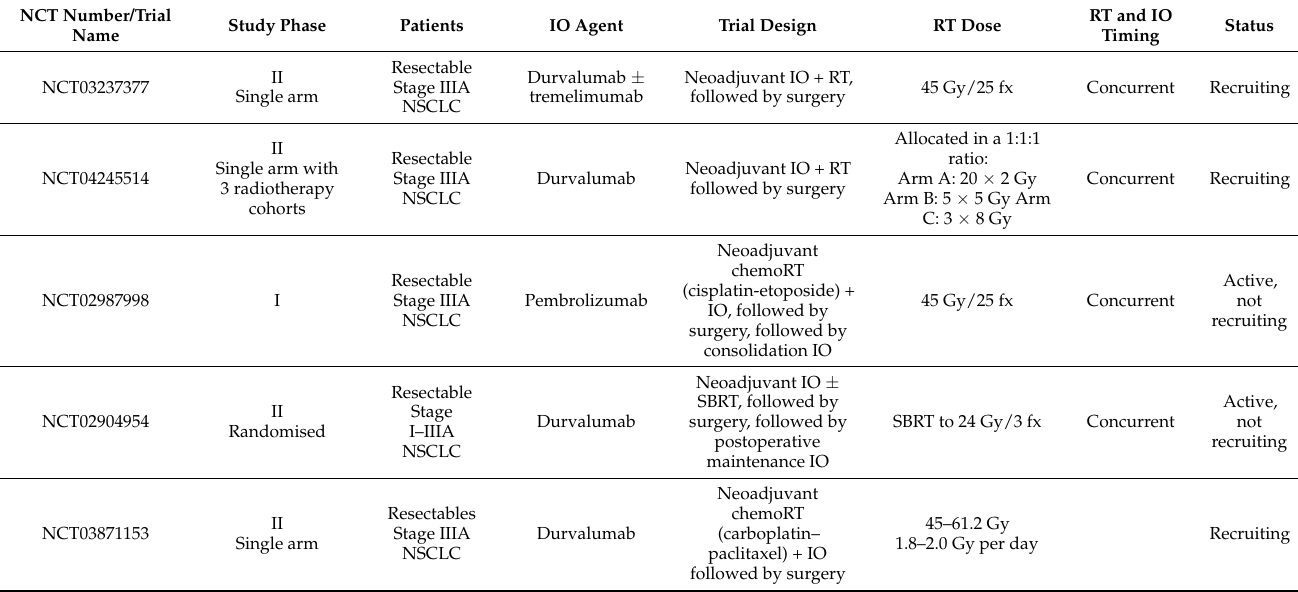
Table 4. Ongoing radio-immunotherapy studies in stage III